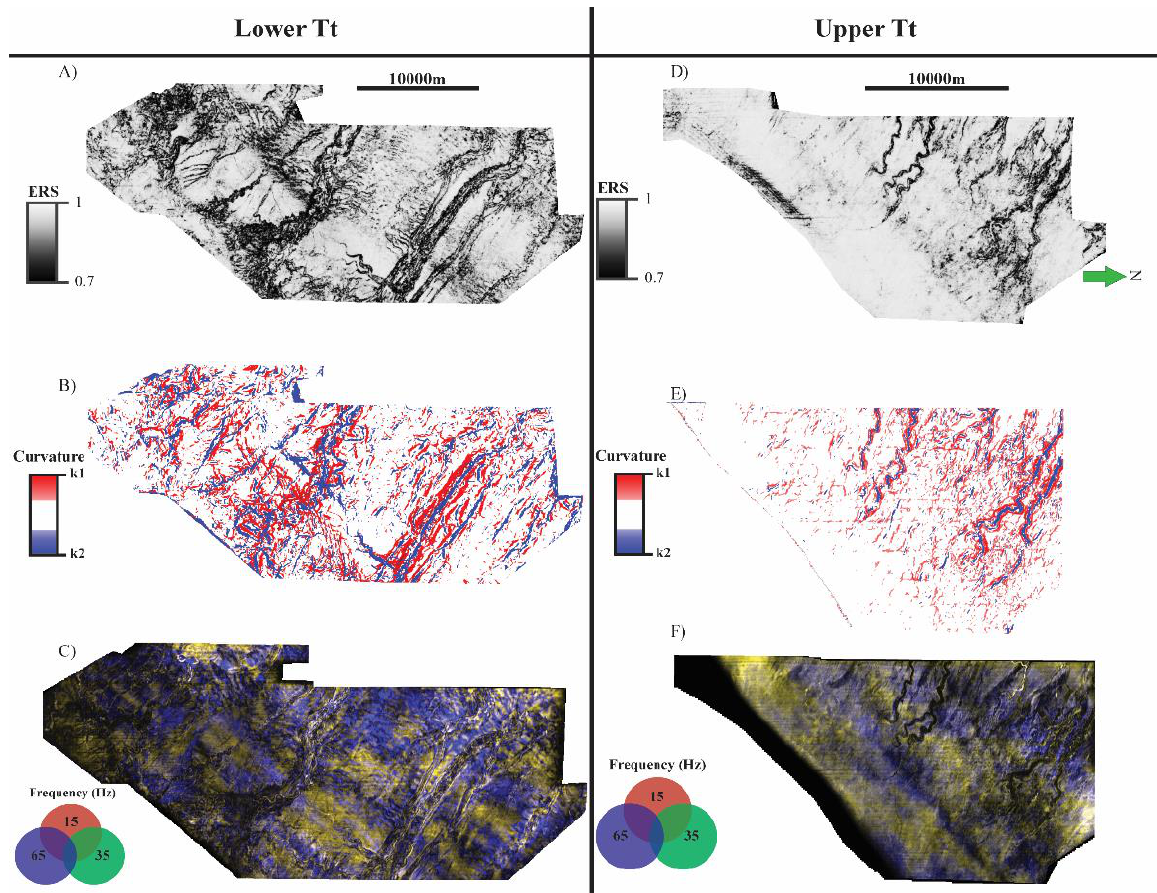
Figure 6. Attribute extractions along Lower Tt (lower Tt) and Upper Tt (late Tt) in the Pipeline-3D seismic survey. ( A ): Energy ratio similarity (ERS). ( B ): k1 and k2 curvature. ( C ): Red – green – blue (RGB) blend of spectral decomposition frequency volumes. ( D ): ERS along Upper Tt. Note how channels are no longer continuous across the survey and initiate in the central portion. ( E ): k1 and k2 curvature. ( F ): RGB blend of spectral decomposition frequency volumes.